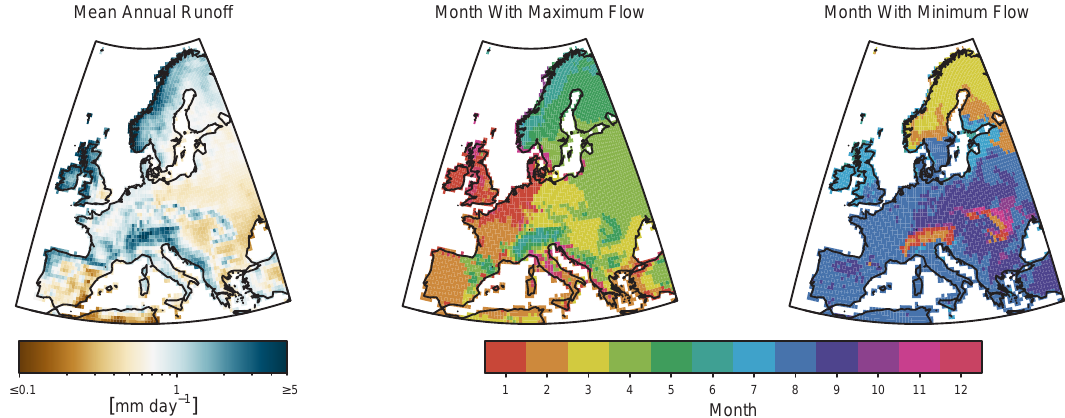
Figure 13. European runoff climatology (1964–2000). Left: long-term mean daily runoff rates. Centre: maximum month of the long-term mean annual cycle. Right: minimum month of the long-term mean annual